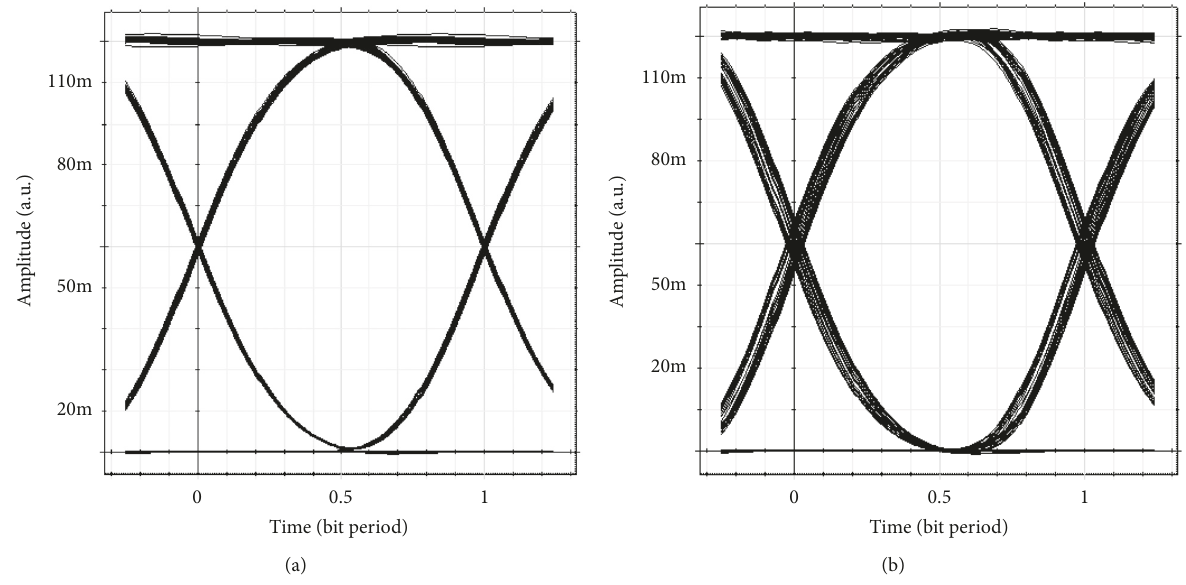
Figure 11: Eye diagrams for channel spacing in 𝐷 = 2 ps/nm/km: (a) 50 GHz; (b) 25 GHz.